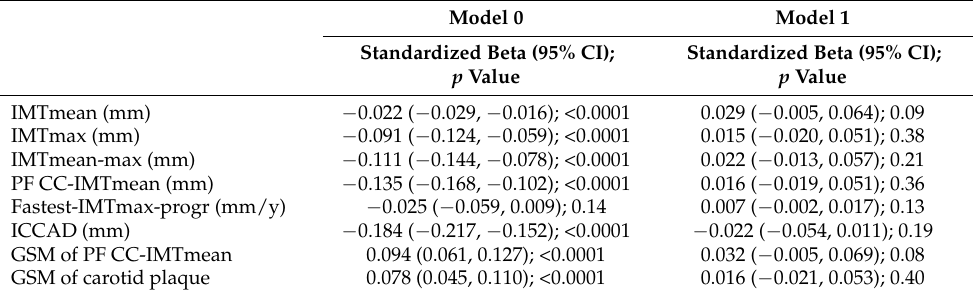
Table 3. Multivariable relationships between plasma PCSK9 levels and carotid IMT phenotypes, ICCAD and echolucency (Grey Scale Median;